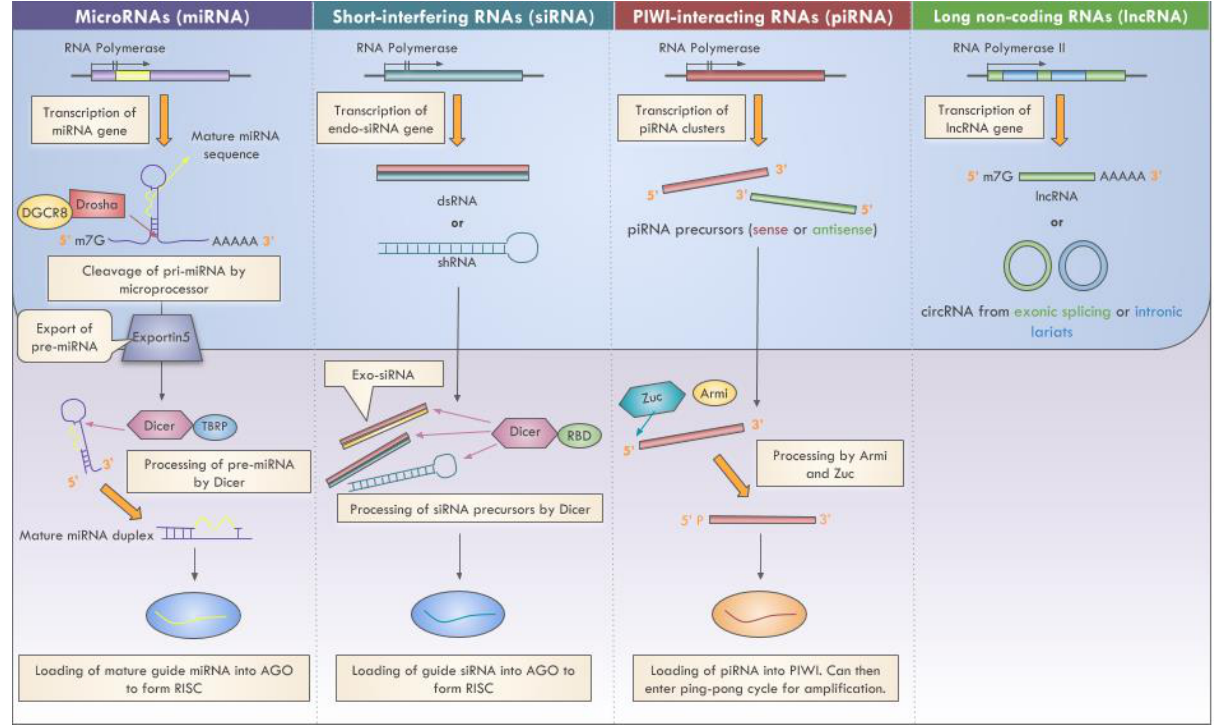
Figure 2. Biogenesis of select ncRNAs.